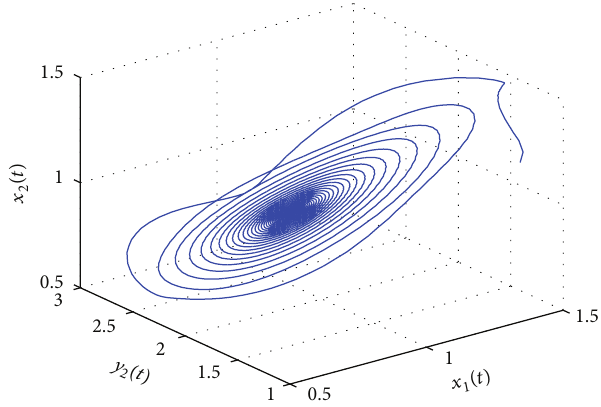
Figure 8: The phase plot of the states 𝑥 1 , 𝑥 2 , 𝑦 2 for 𝜏 2 = 7.7500 < = 9.9183 . 𝜏 20